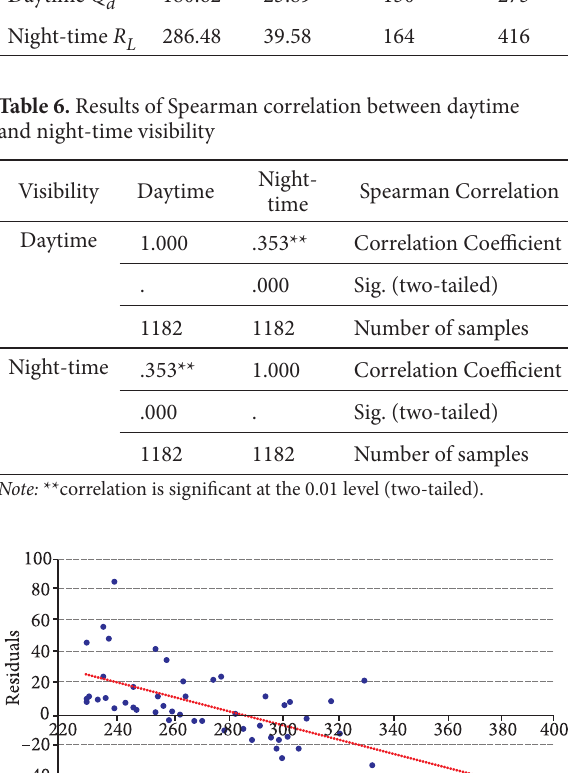
Table 5. Mean visibility value and mean deviations between the daytime and night-time visibility Visibility, Mean mcd/lx/m 2 value